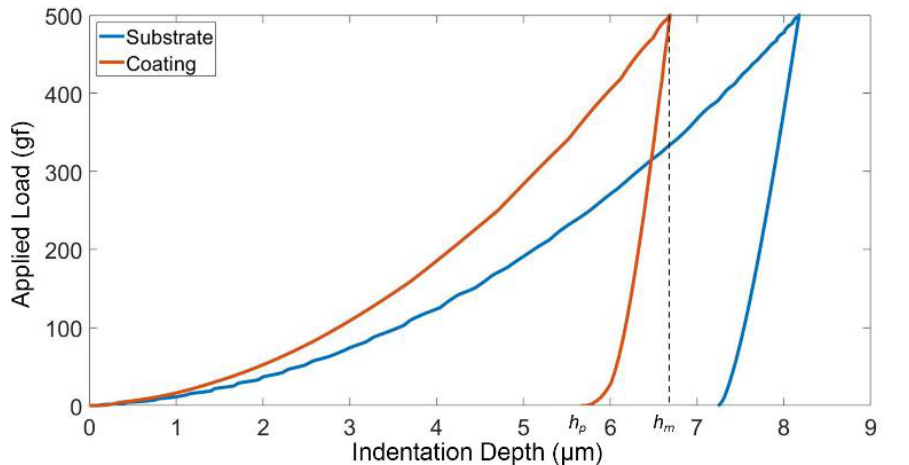
Figure 9. Numerical load – depth curves of the Ti-6Al-4V substrate and MMNC-coated models with a 500 gf maximum load.